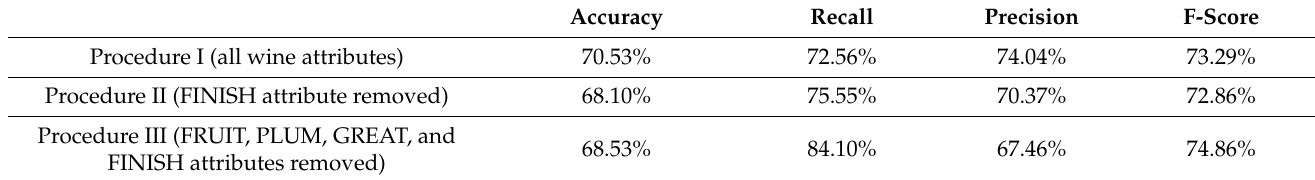
Table 4. Results of the performance of the KNN algorithm on the wine dataset with a K-value of 85.